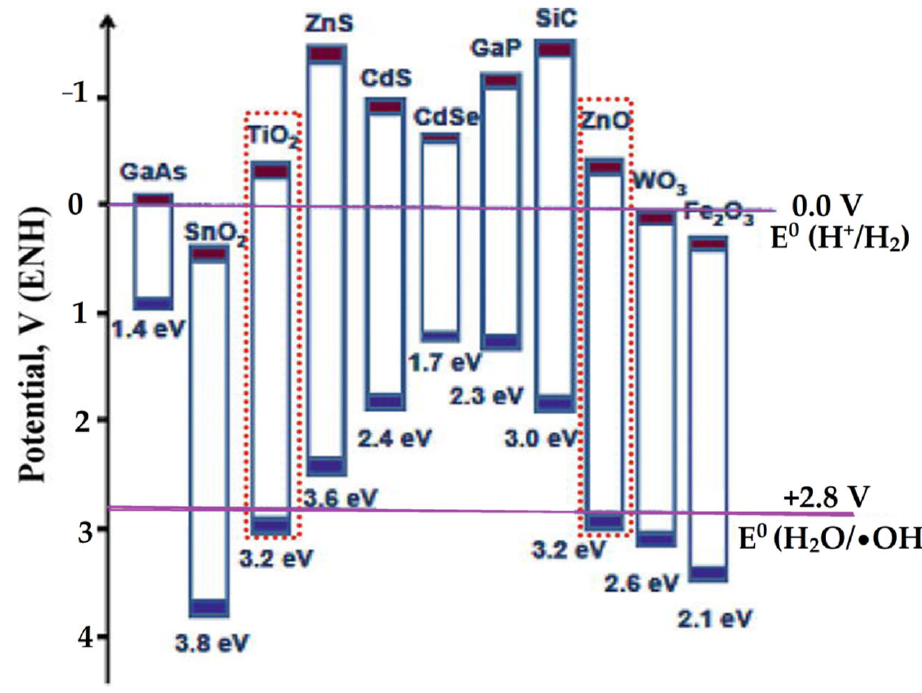
Figure 13. Potential diagram of some semiconductors.